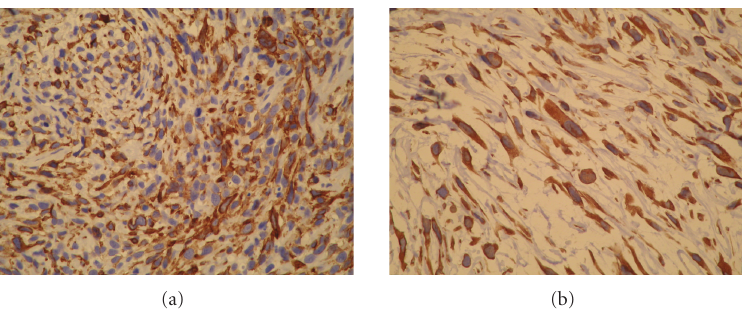
Figure 2: Immunohistochemistry demonstrates that tumor cells express smooth muscle actin (a) and vimentin (b).